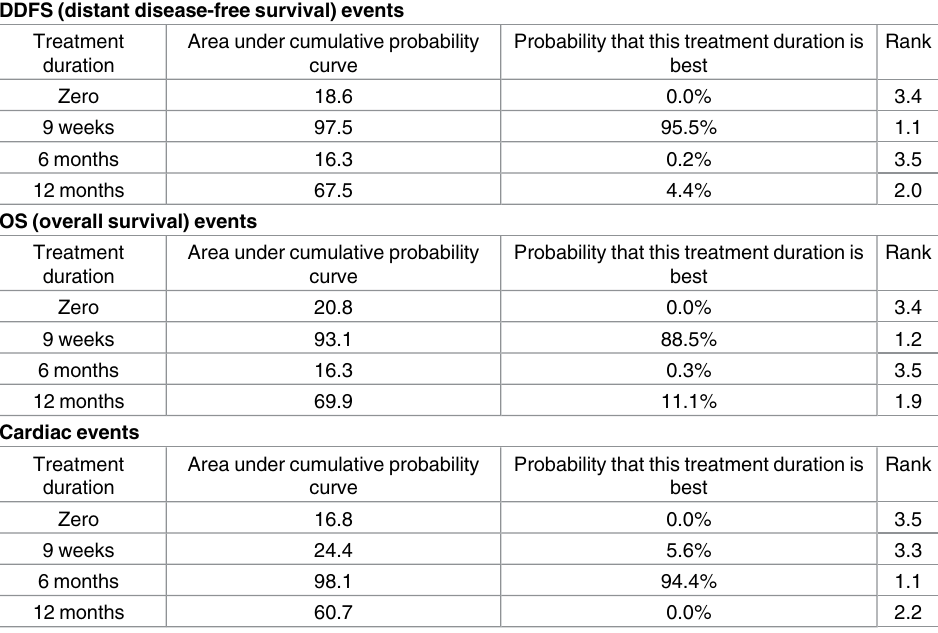
Table 3. SUCRA rankings for network including BCIRG006, FinHer and PHARE.